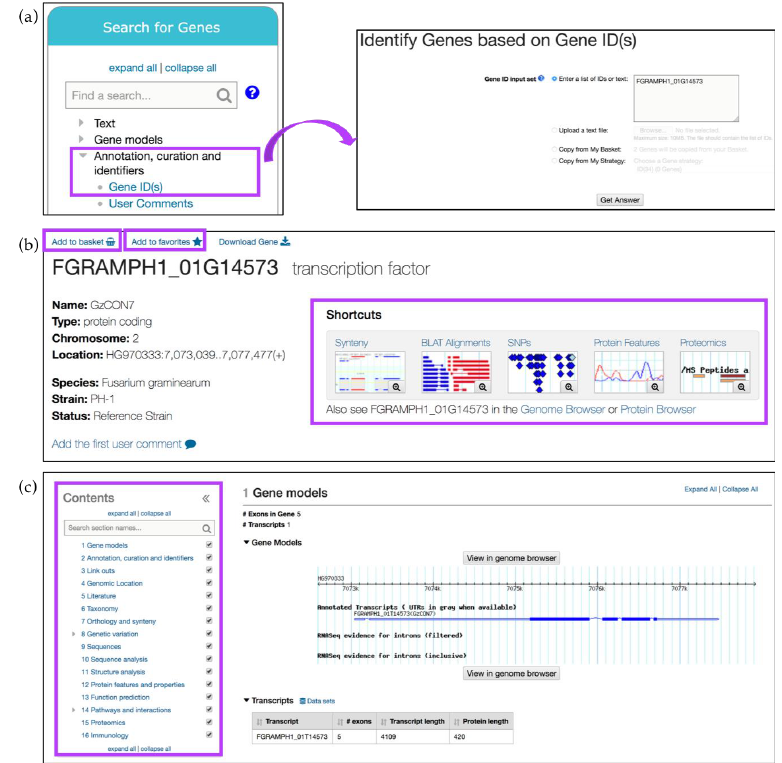
Figure 2. Simple searches and gene record pages. ( a ) A Gene ID search can be initiated from the main component section, Search for Genes option, Annotation, curation and identifiers submenu (highlighted in purple); ( b ) Gene record page can be saved or bookmarked via Add to basket or Add to favorites links, respectively (highlighted in purple). Thumbnail Shortcuts (highlighted) provides easy navigation to key datasets; ( c ) Additional gene record sections can be quickly identified via the searchable Contents menu on the left (highlighted in